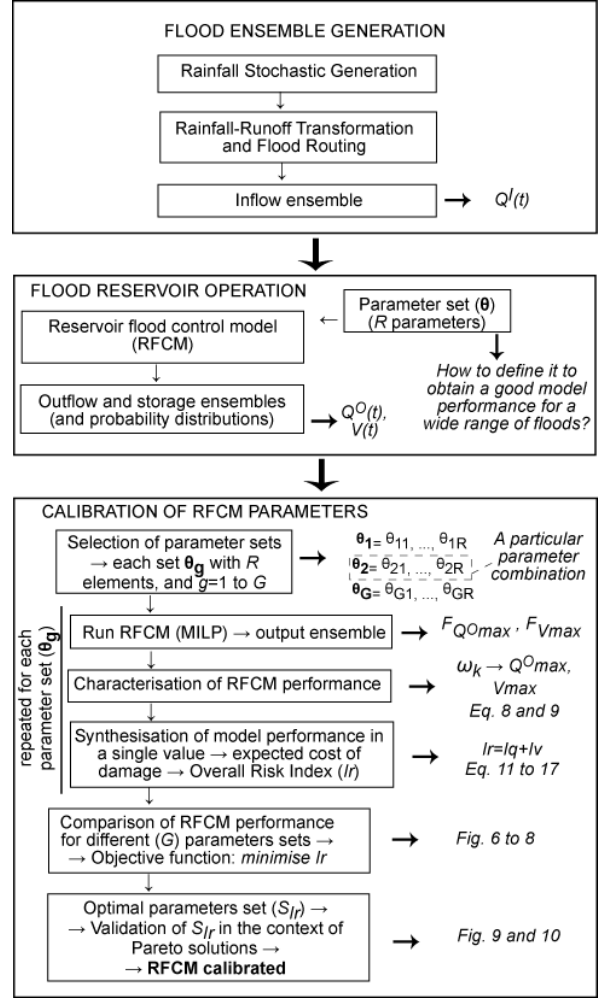
Figure 2 . Implementation of the methodology 777 Fig. 2. Implementation of the